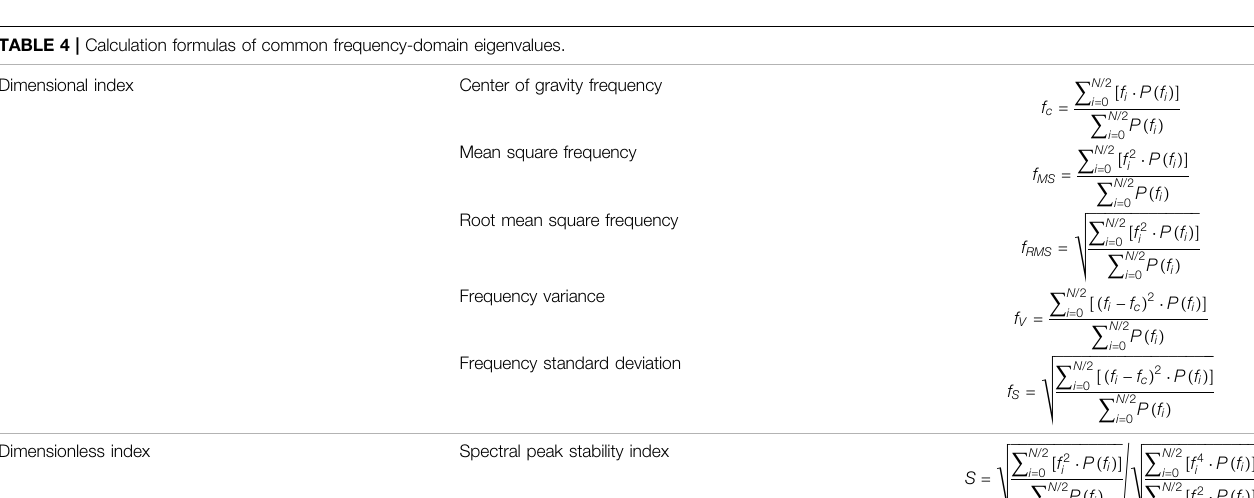
TABLE 4 | Calculation formulas of common frequency-domain eigenvalues.